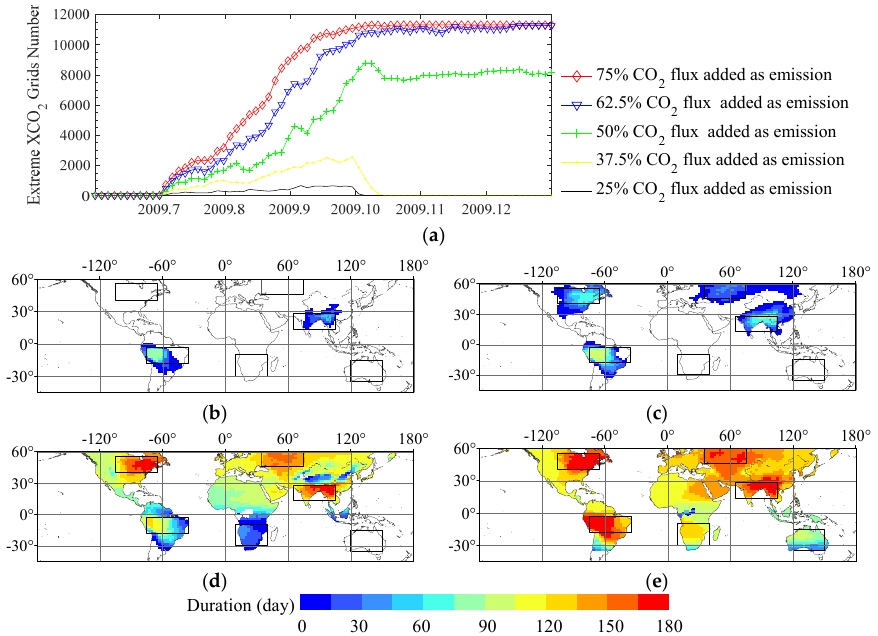
Figure 8. Detected results of extreme high XCO 2 grids number with different emission increases added to the input CO 2 flux, from 1 July to 31 September 2009, described in Section 3.3. Temporal statistical grid number is shown in ( a ), and spatial distribution of detected emission ratio is shown in ( b – e ). Corresponding changed XCO 2 are shown in Figure S3. ( a ) Time series of influenced grids of various increases in biospheric CO 2 fluxes as percentages added as emission; ( b ) detected grids with 25% CO 2 flux as emission; ( c ) detected grids with 37.5% CO 2 flux as emission; ( d ) detected grids with 50% CO 2 flux as emission; ( e ) detected grids with 62.5% CO 2 flux as emission.